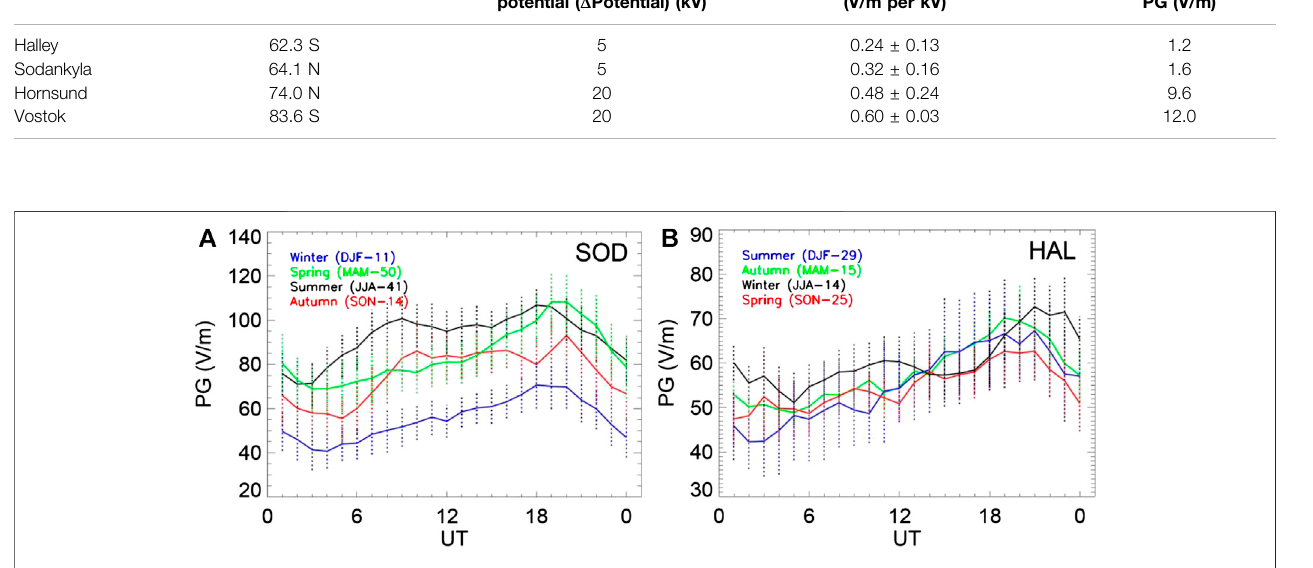
Frontiers in Earth Science |